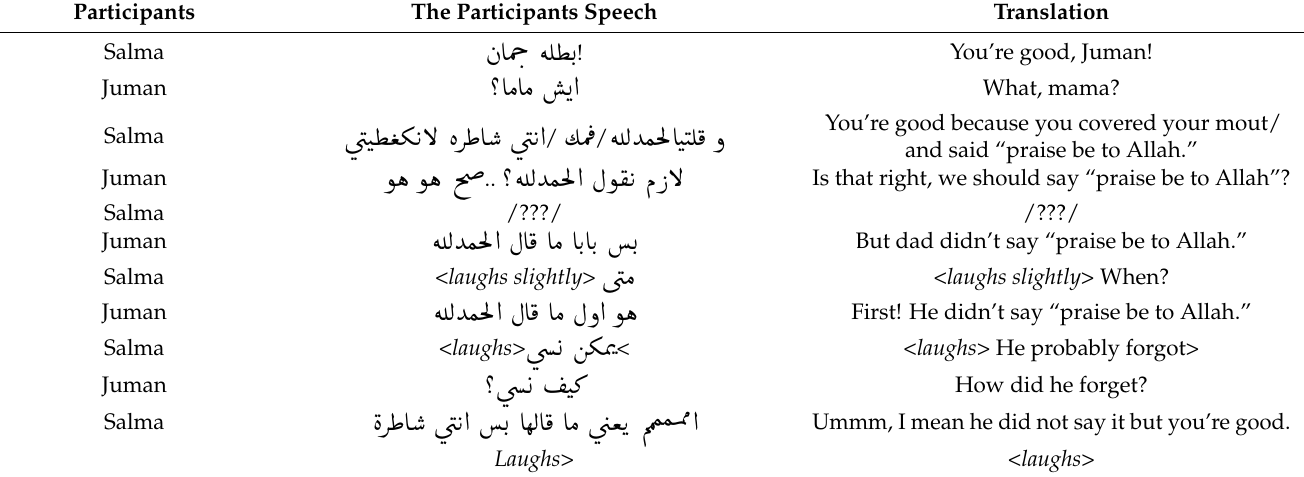
Table 7. Excerpt